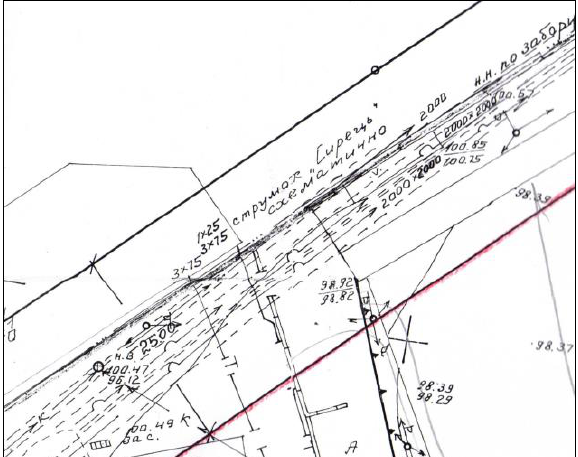
Figure 1a. A topographic plan fragment, scale 1: 500, drawn up in 2012, in which the hydronomic "Syrec stream" near the channel in the concrete collector is